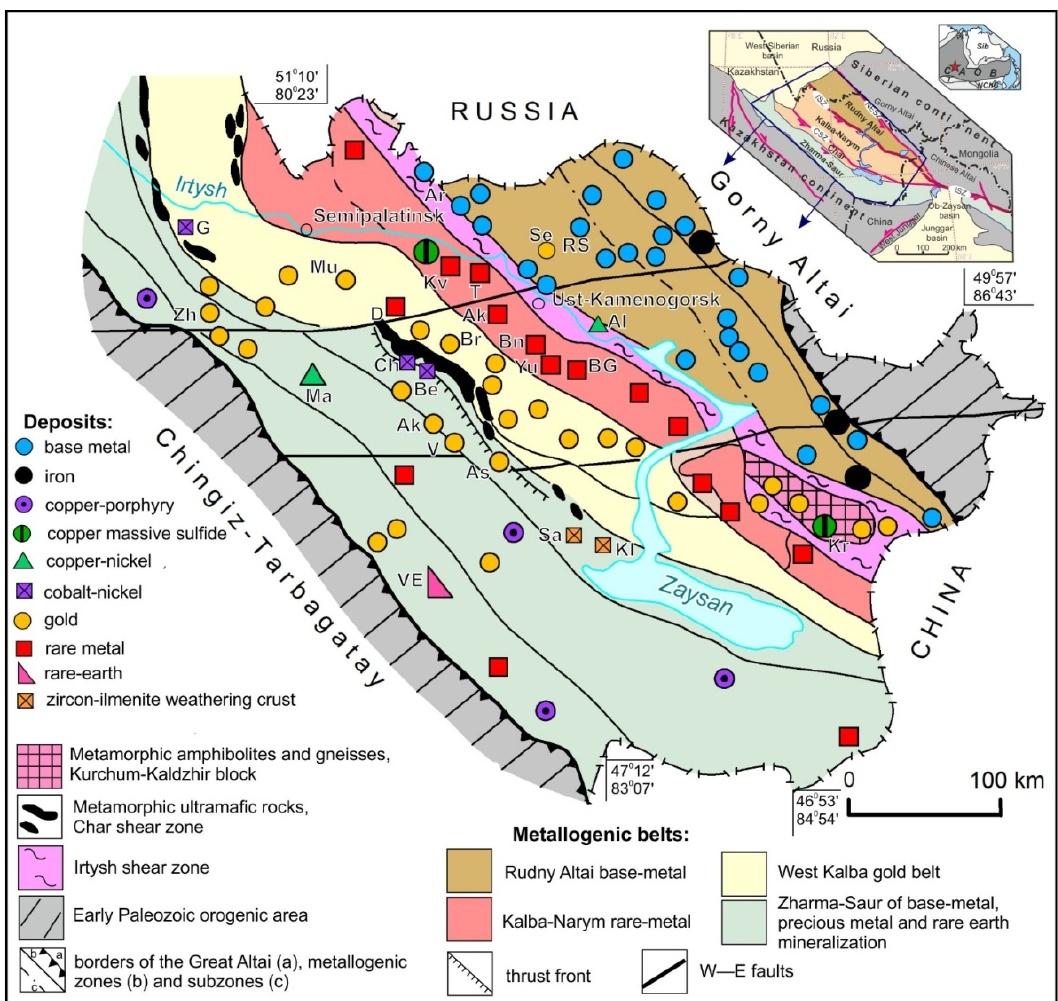
Figure 1. Metallogenic zones of the Great Altai. Arabic numbers stand for names of mineral deposits: RS = Ridder-Sokolny; Ar = Artemiev; Bn = Bakennoye; BG = Belaya Gora; Kr = Karchiga; Br = Bakyrchik; Ak = Akzhal; V = Vasil’evka; Zh = Zhanan; VE = Verkhnee Espe; Ch = Charsk; Mu = Mukur; G = Gornostaevskoe; Ma = Maksut; Yu = Yubileinoe; Se = Sekisovka; Al = Alisher; Kv = Kvartsevoe; T = Tochka; Ak = Akhmetka; As = Ashaly; D = Delbegetey; Be = Belogorskoe; Sa = Satpaevskoe; Kl = Karaotkel. The insert shows the layout and tectonic zoning of the Great Altai territory. The terranes are separated by large regional zones: CSZ—Char shaer zone; ISZ—Irtysh shear zone; NESZ—Notrh-Eastern shear